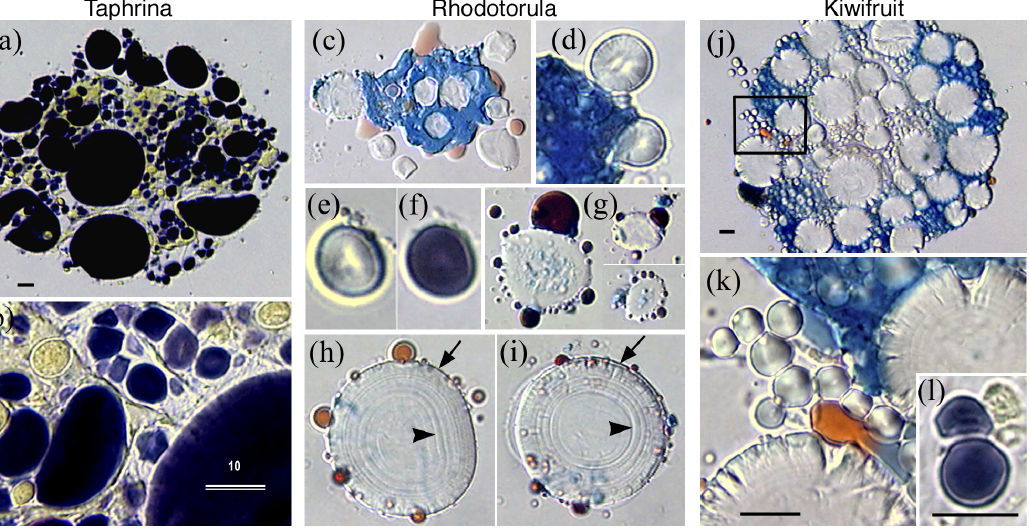
Figure 7. Starch grains develop within mycosomes from fungi and plants. (a–i) Starch grains from Taphrina and Rhodotorula mycosomes filtered 0.8 m m. (a–b) A Taphrina protoplast containing numerous starch grains and static yeast cells (MR stain). (b) An enlarged portion of (a) showing the yeast cells, some of which develop as division products of starch-Ms. (c–i) Rhodotorula, AB/SIV stain; (c) Cytoplasmic fungal protoplasts contain starch granules that (d) develop within the vacuole-like PMO. (e–f) A starch-Ms stained with AB (e), then with MR (f). (g) Starch-Ms often form lipoid- Ms from their boundary. (h–i) Large granules show the bounding Ms-membrane (arrows) and typical growth rings (arrowheads). (j) A fungal protoplast cultured from kiwifruit cell extract is packed with large and small Ms-starch grains (AB/SIV stain). (k) An enlargement of boxed area (j), showing chain-like division of Type II Ms-starch grains. (Inset l): A dividing Type II starch-Ms, photographed inside a kiwifruit cell (MR stain). Bars =10 m m. Use bar (b) for c through i.